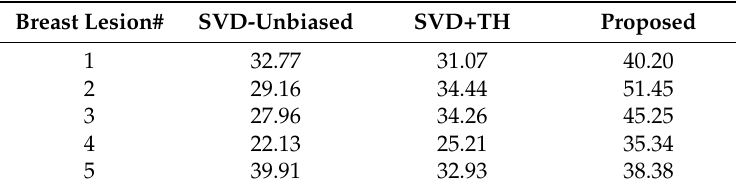
Table 2. SNR values in dB obtained by applying three different filtering methods on microvasculature images of five breast lesions. Breast Lesion#